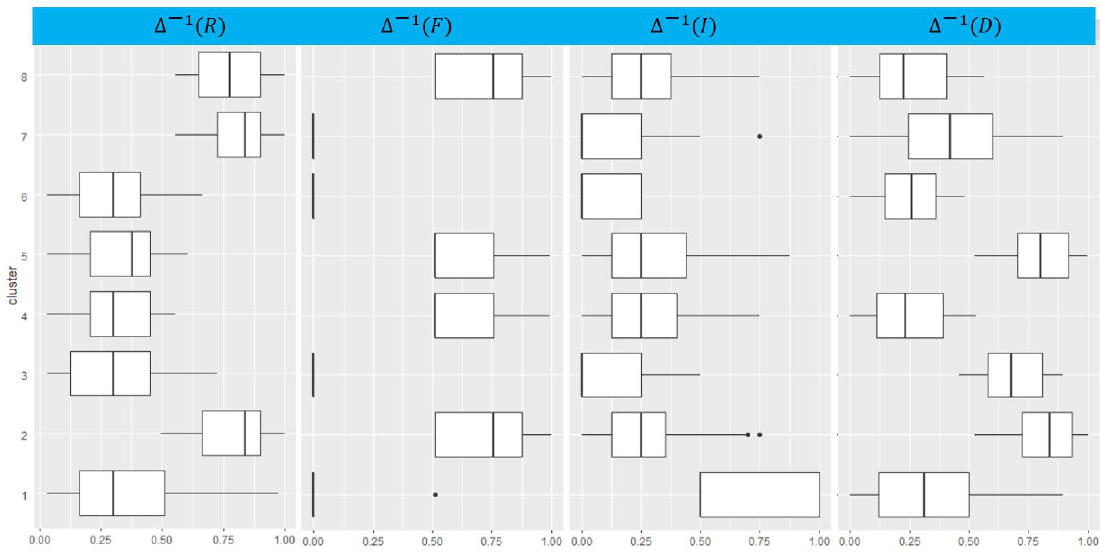
Figure 9. Distribution of All Customers by Segment.